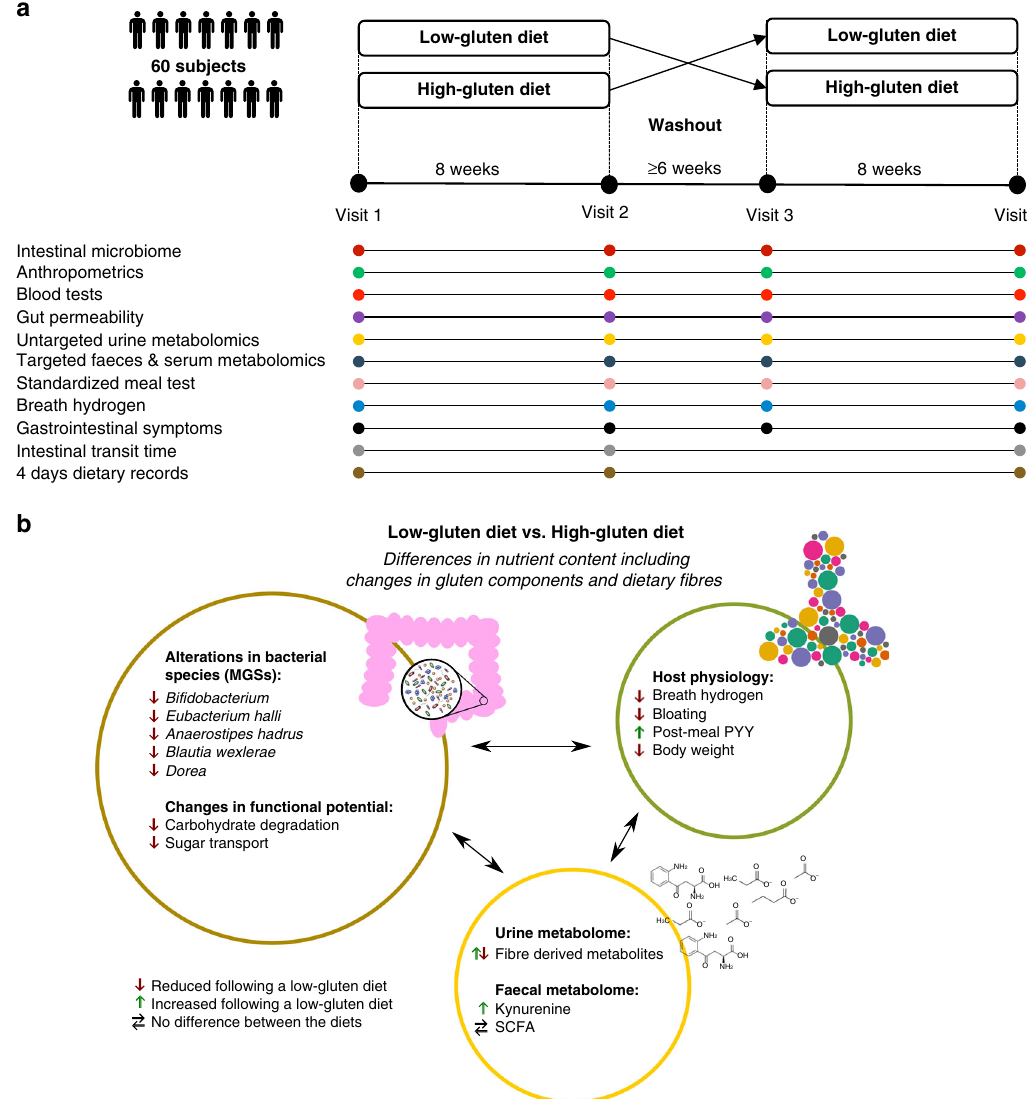
Fig. 1 Experimental design, data overview and summary of the cross-over trial. a The study was a randomised, controlled, cross-over trial with two 8-week dietary intervention periods separated by a washout period of at least six weeks, comparing the effects of a low-gluten diet and a high-gluten diet on the gut microbiome (prede fi ned primary outcome), untargeted urine metabolome and measures of host physiology 12 . Time points for data collections are indicated by circles in the lower part panel ( a ). b Effects of a low-gluten diet compared with a high-gluten diet on the intestinal microbiome, urine/faecal metabolome and markers of host physiology in apparently healthy adults. Measured variables that were found to be reduced (red arrow), increased (green arrow) or unchanged (black horizontal arrows) following the low-gluten diet intervention compared with the high-gluten diet intervention are listed. MGS metagenomics species, PYY peptide YY, SCFA short-chain fatty acids. The person icon and molecular structure images for the acetate anion, butyrate ion, propionate ion and kynurenine were obtained from Wikimedia Commons, released under public